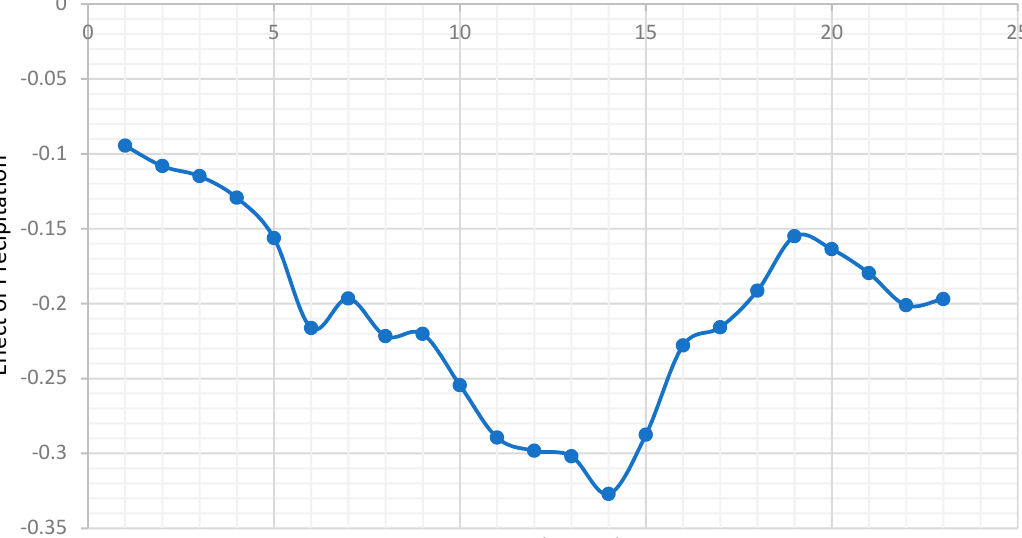
Figure 5. E ff ects of temperature. Figure 5. Effects of temperature.